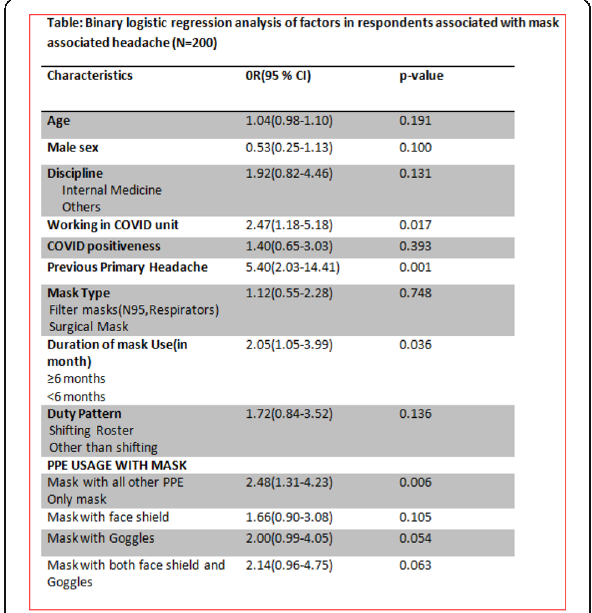
Fig. 1 (abstract P0414). See text for